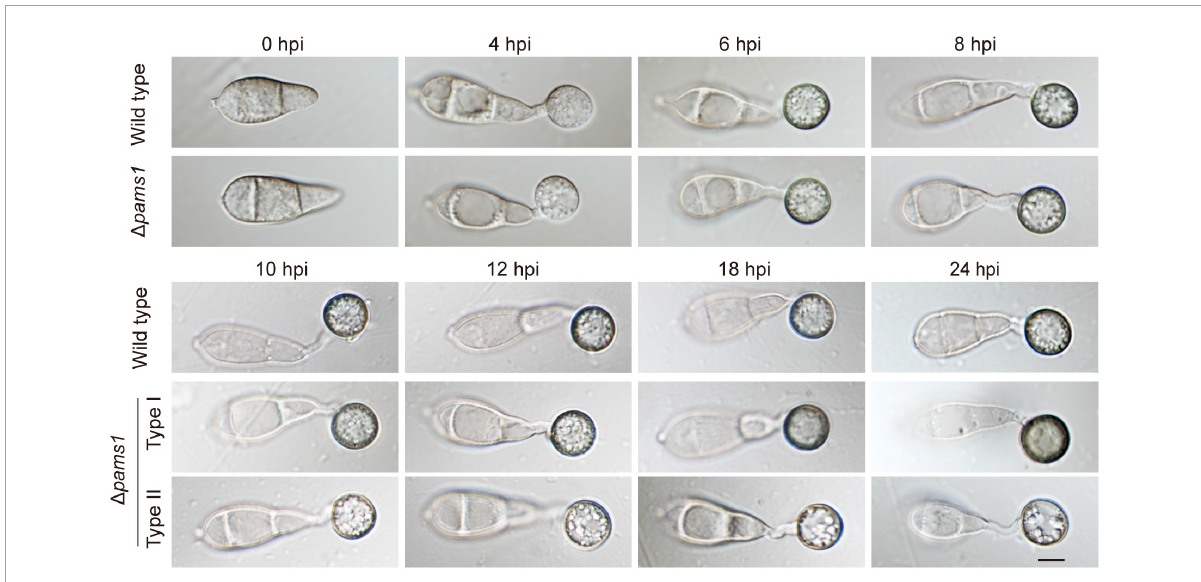
FIGURE4 Characteristics of (cid:49) pams1 in appressorium formation. Appressoria formed by (cid:49) pams1 and the wild type at 0, 4, 6, 8, 10, 12, 18, and 24 hpi. (cid:49) pams1 formed two types of abnormal appressoria (types I and II) after 10 hpi. Scale bar, 5 µ